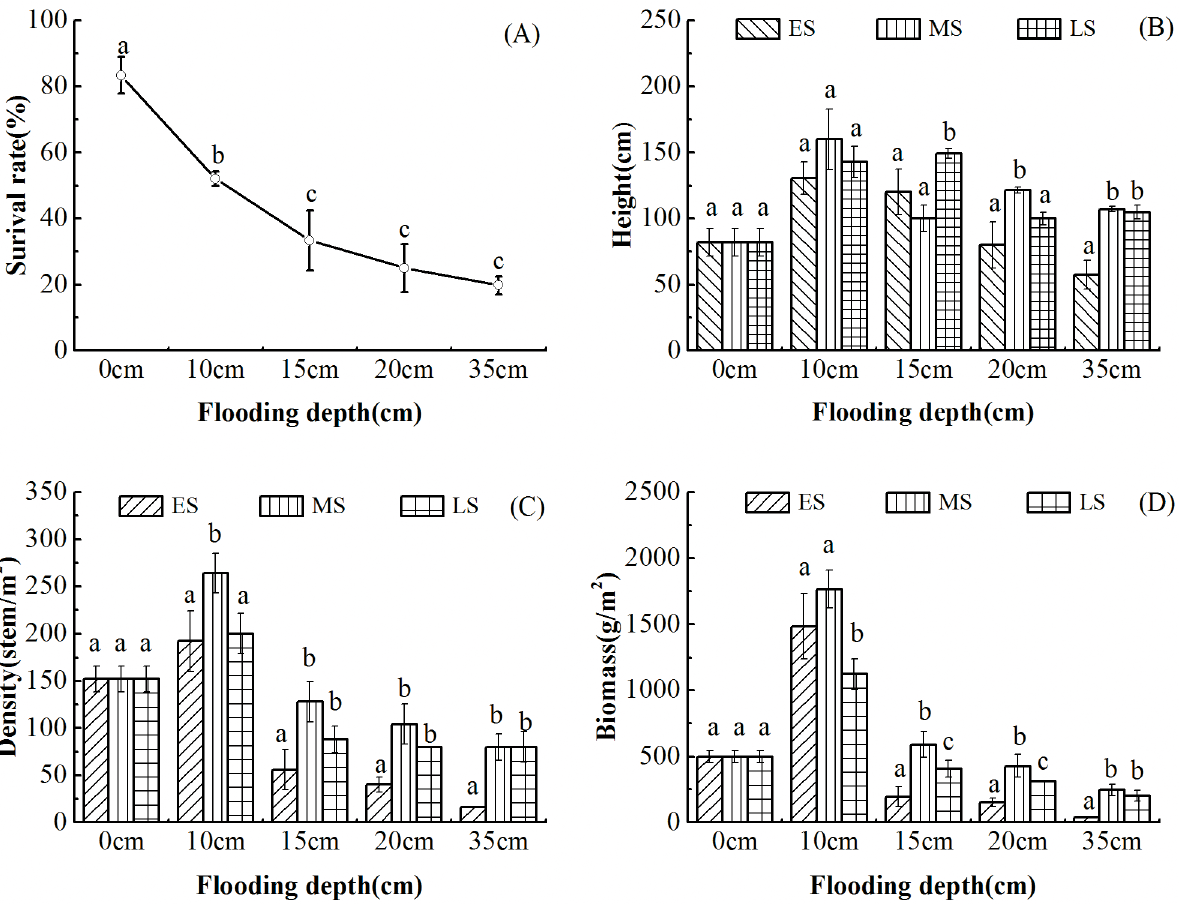
Fig 2. Effects of water supplement on reed survival (A), height (B), density (C) and biomass (D). Different lower-caseletters indicated differences in reed survival (A), height (B), density (C) and biomass (D) subjectedto different water depth.